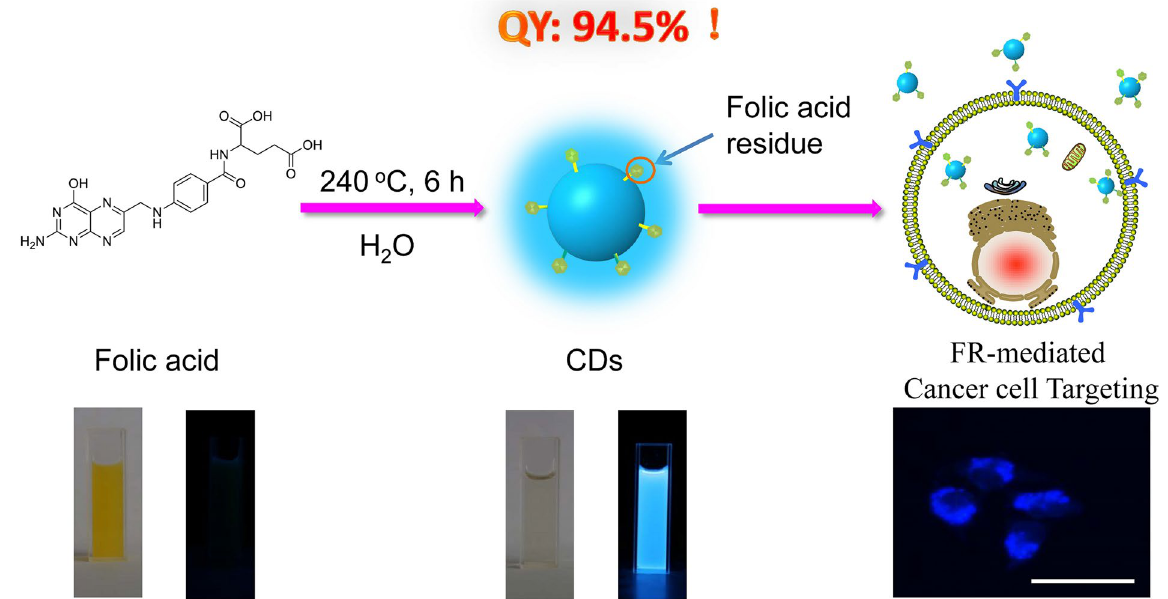
Figure 1. Schematic illustration of the synthesis of folic acid (FA)-derived CDs and their application for folate receptor (FR)-mediated cancer cell targeting.